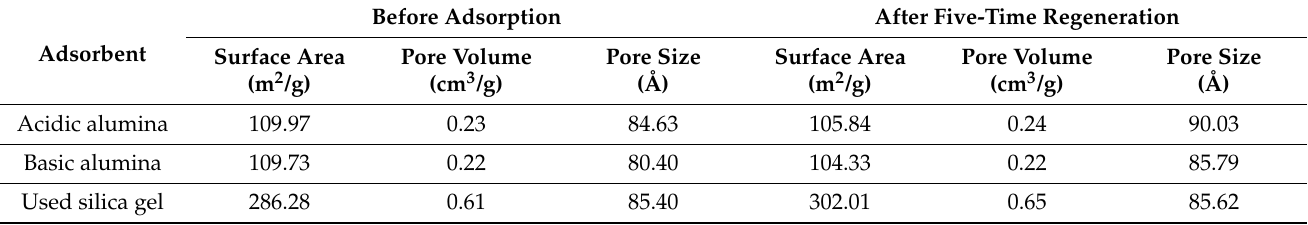
Table 2. BET surface area analysis of different adsorbent